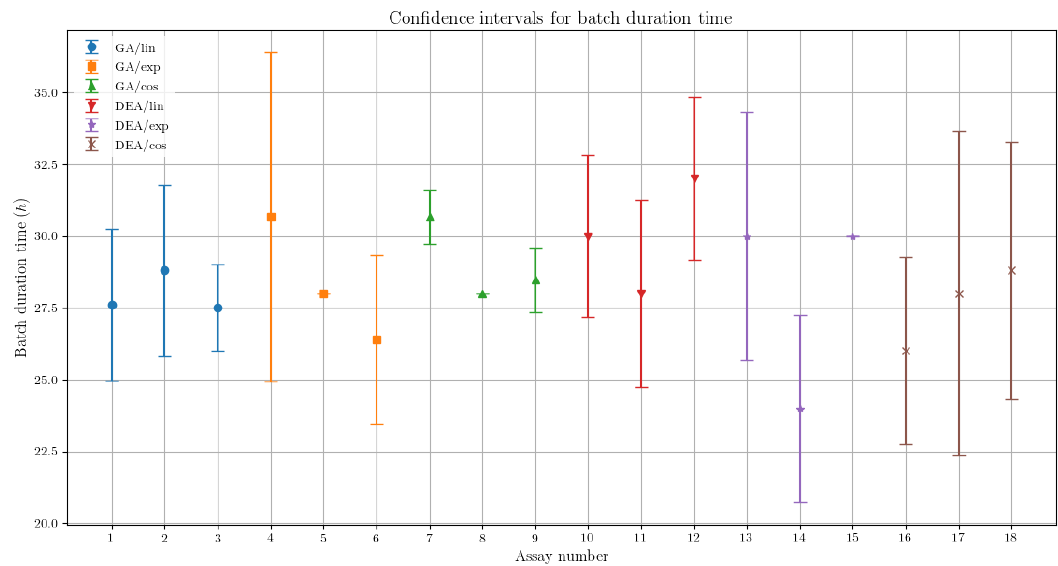
Figure 5. Confidence interval comparison between the assays for the batch duration time, presenting the variability respective to each optimization algorithm and feed rate